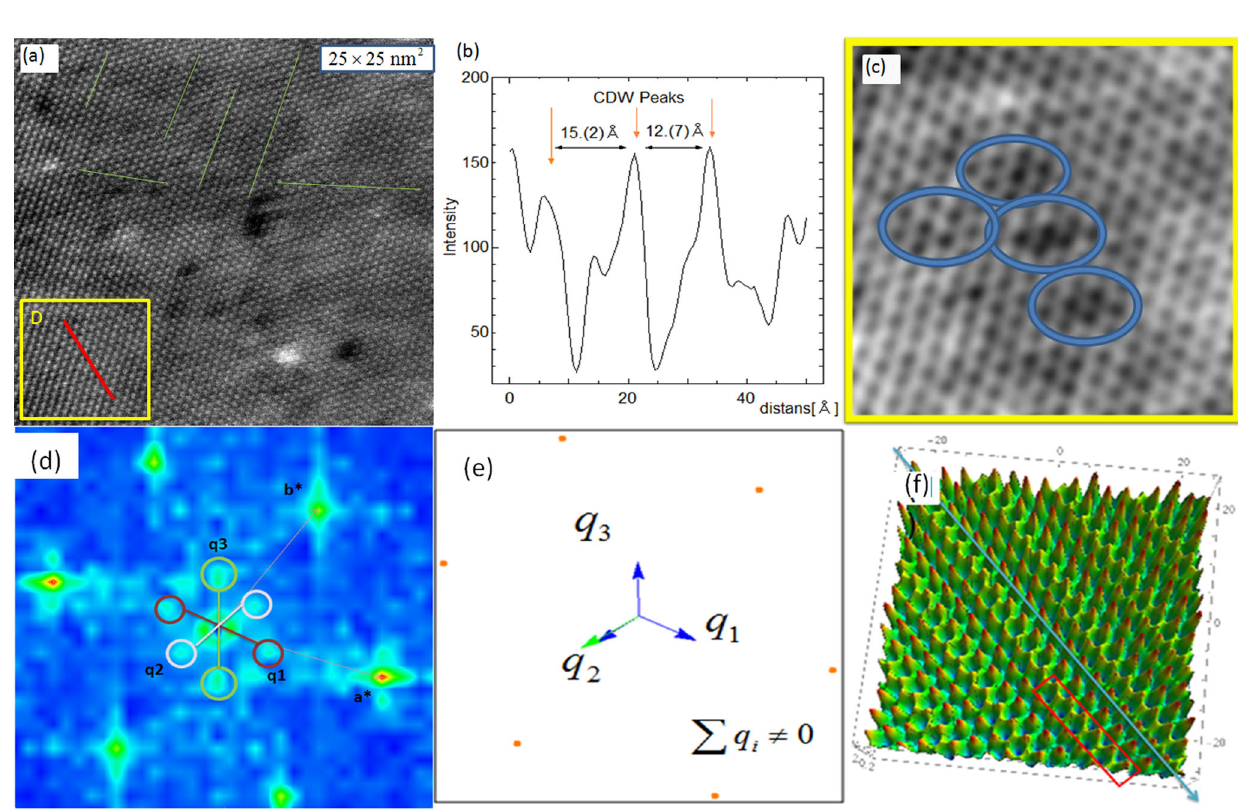
Fig. 5 Mono-layer 1T-TaS 2 a STEM image of mono-layer 1T-TaS 2 at room temperature. There are shadow crevasses (Shown by green lines , see supplementary material 2 for an enlarged view with eyeguides). These correspond to areas with few scatterers. D shows domains with ordered structures. b An intensity plot along the red line in D. The orange arrows show super-lattices enhanced in Fig. 5(c). c An enlarged image of D in Fig. 5(a) with inverted contrast. The black hexagons shown by the blue ellipses are super-lattices. Super-lattices do not form honeycomb lattices. d FTI of D in Fig. 5(a). The transformed region is tiny, so the peaks are broad. However, we con fi rm the presence of triple q vectors. e Satellite patterns of the mono-layer sample. The orange points are Bragg peaks of the lattice. The blue arrows are nesting vectors. The green arrow is - q 1 - q 2 which clearly differs from q 3 , so triple q condition q 1 + q 2 + q 3 = 0 is broken. f The charge con fi guration is reproduced from the satellites in Fig. 5 (e). The structures correspond to shadow crevasses ( red frame ) and stripe structure ( blue arrow